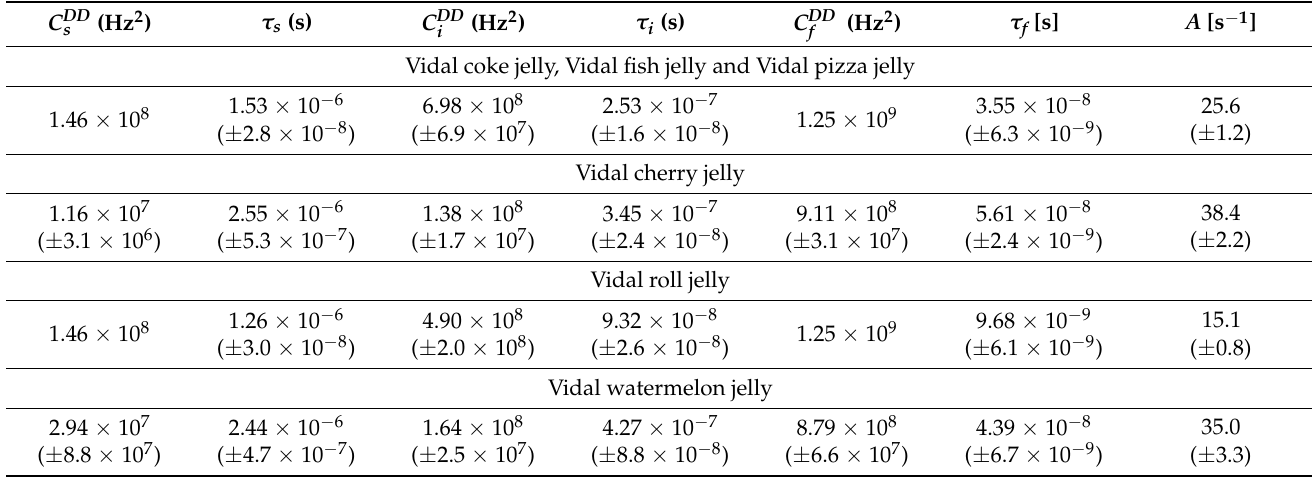
Figure 6. 1 H spin-lattice relaxation data for Vidal coke jelly, Vidal fish jelly and Vidal pizza jelly at 323 K ( left ) and Vidal cherry jelly at 323 K ( right ) reproduced in terms of the model described in the theory. The fit ( R 1 ) shown as a black solid line has been decomposed into relaxation contributions associated with slow, intermediate and fast dynamics, R 1 s , R 1 i and R 1 f , respectively. The frequency independent term, A , is also indicated. Table 2. Parameters characterizing molecular dynamics in Vidal jelly at 323 K. (In case there are no parameter uncertainties provided, the parameters have been set to the value given in the table and